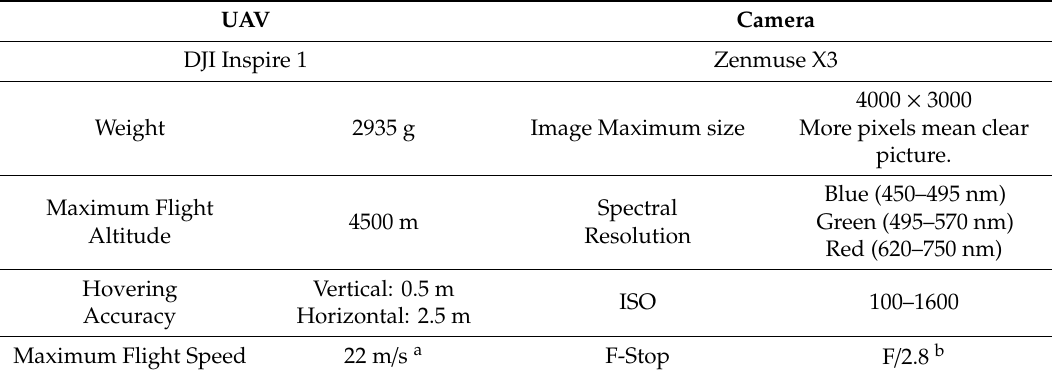
Figure 1. The study area (Daehyun-dong in Daegu, South Korea); location is marked with a red asterisk in the small-scale map. A total of 24 sample rooftops (three samples per color) are presented as small letters (a: white, b: gray, c: blue, d: cyan, e: red, f: green, g: black, h: brown). Different rooftops of the same color are indicated as numbers such as a1, a2, a3. The magnified portions of the 8 sample rooftops indicated as number 1 are presented in Figures 4 and 5. Table 1. UAV and visible camera specifications.